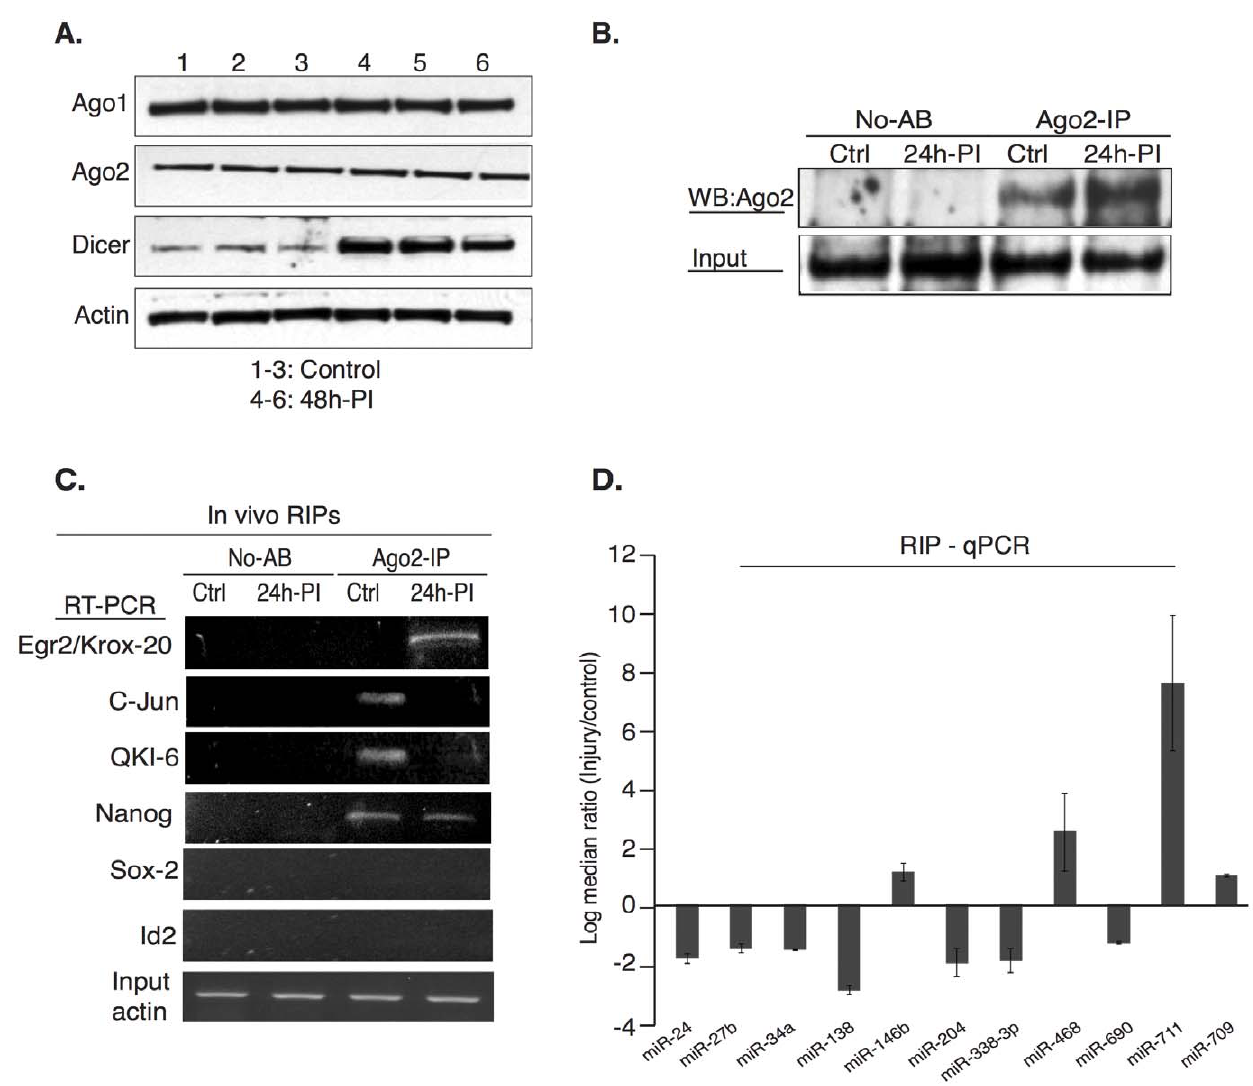
Figure 4. miRNAs induce post-transcriptional gene silencing through association with Ago-2 in functional complexes. (A). Protein expression of Ago-1, Ago-2 and Dicer in sciatic nerves before and after nerve injury to confirm the expression of the miRNA processing machinery proteins. Actin was used as a loading control. (B) Cytoplasmic lysates isolated from control sciatic nerves and injured distal segments (10 nerves each) were immunoprecipitated with Ago-2 antibody (Cell Signaling, USA) or IgG control. A portion (1/3 rd ) of the sample was used for each of the analysis and the experiment was repeated twice. Input, No-Antibody (No AB) and Ago-2 immunoprecipitated protein was analyzed by western blotting with Ago-2 antibody, which shows enrichment of Ago-2 in the 24 hour post-injury samples. (C). For RNA-IPs (RIPs), mRNAs that were co- immunoprecipitated with Ago-2 in vivo, were reverse transcribed using oligo-dT primer and genes of interest were PCR amplified using gene-specific primers (Krox-20 = 1274 bp, C-Jun = 689 bp, Nanog = 753 bp, QKI-6 = 1345 bp, Sox-2 = 958 bp and ID-2 = 588 bp). (D). microRNAs that were co- immunoprecipitated with Ago-2 in complex with their targeted mRNAs, were reverse-transcribed with microRNA specific RT-primers using Multiscribe RT kit. Ago-2 associated microRNAs were detected by real time qPCR with miRNA specific Taqman probe/primer sets. Data were normalized to input and an internal control. Fold difference (2 - DD CT ) in the association of individual microRNAs with Ago-2 protein between injured and control nerves was plotted as log 2 median ratio and error is expressed as standard